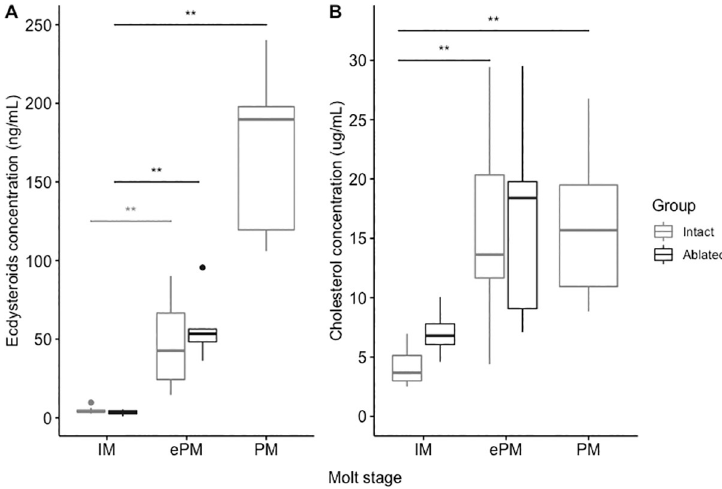
Fig 5. Levels of hemolymph Ecd and cholesterol at different molt stages. The group of animals undergoing natural molt cycle are colored in light grey (Intact) while the group of eyestalk-ablated animals are colored in dark grey (Ablated). (A) Ecdysteroid concentrations (ng/ml) in the hemolymph from intact prepubertal females at intermolt (IM), early premolt (ePM) and intermediate premolt (PM) and the corresponding stages from eyestalk-ablated adult females (D7 after ablation). (B) Cholesterol (free and cholesteryl esters) concentrations ( μ g/ml) from intact prepubertal females at intermolt (IM), early premolt (ePM) and premolt (PM) and the corresponding stages from eyestalk-ablated adult females (D7 after ablation). The levels of both Ecd and cholesterol were not statistically different at IM and ePM between natural and ablated animals ( P > 0.05, Students’ t-test). Statistical difference between IM, ePM and PM in a natural molt stage was evaluated using non-parametric Kruskall-wallis and Dunn test post-hoc ( P < 0.05). The dots represented outliers in the dataset. mL ± 2.1 ng/mL (n = 8); higher levels at ePM (47.1 ng/mL ± 29.0 ng/mL) (n = 7) and the high- est level at 169.7 ng/mL ± 50. 5 ng/mL (n = 11) (Fig 5A).